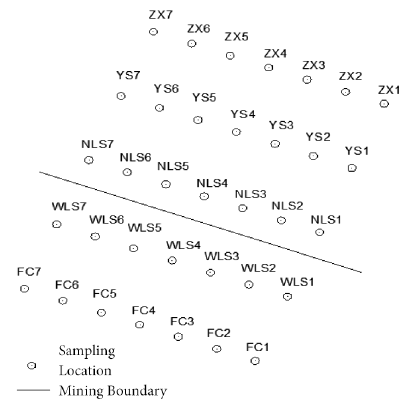
Figure 2. The layout of sampling points in the aeolian sand region